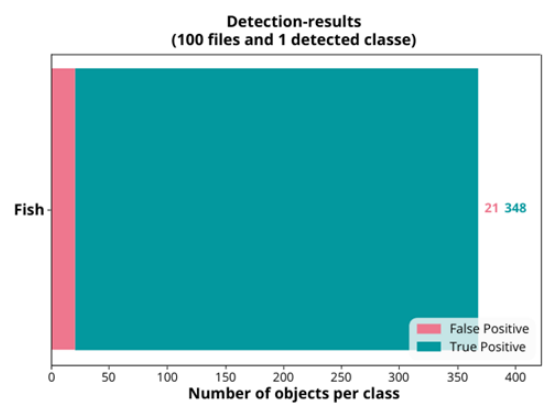
Figure 12 . False positive and true positive for 100